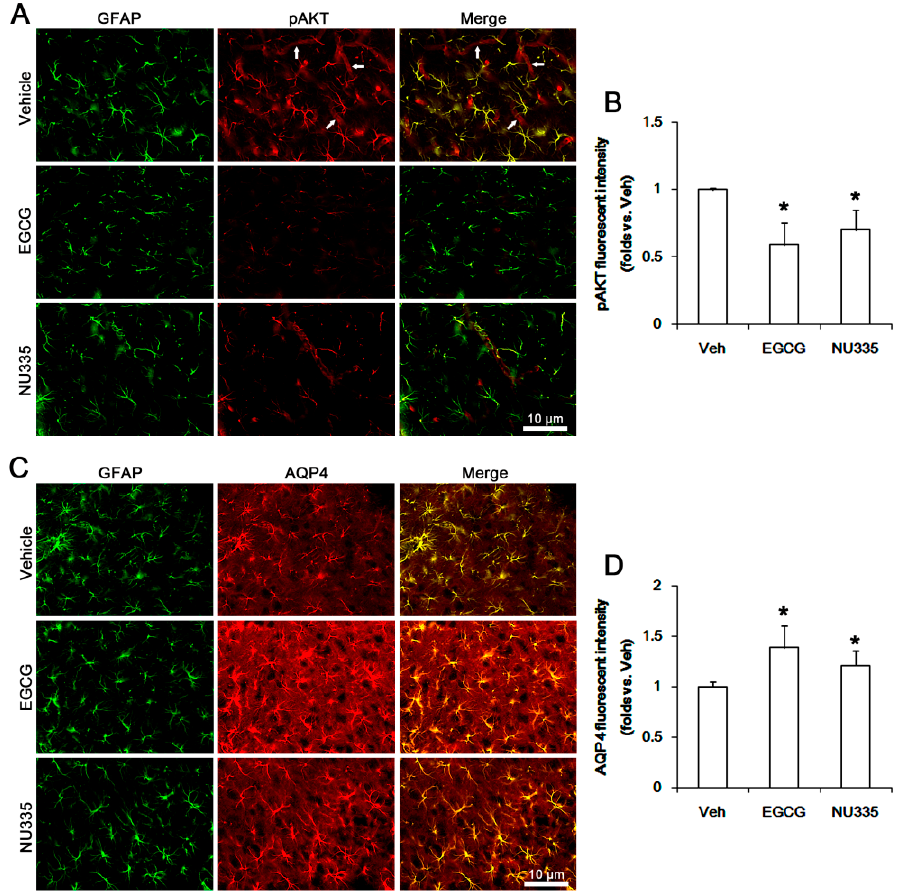
Figure 7. Effects of EGCG and NU335 on pAKT and AQP4 levels in the PC under physiological condition. pAKT signals are observed in endothelial cells (arrows, upper panels in A) and astrocytes. EGCG and NU335 decrease pAKT levels in endothelial cells and astrocytes. However, they increase astroglial AQP4 expression. ( A ) Representative images for pAKT signals in the PC. ( B ) Quantification of the effect of EGCG and NU335 on pAKT fluorescent intensities ( n = 7, respectively). Error bars indicate S.E.M. Significant differences are * p < 0.05 vs. vehicle-treated animals. ( C ) Representative images for AQP4 signals in the PC. ( D ) Quantification of the effect of EGCG and NU335 on AQP4 fluorescent intensity ( n = 7, respectively). Error bars indicate S.E.M. Significant differences are * p < 0.05 vs. vehicle-treated animals.